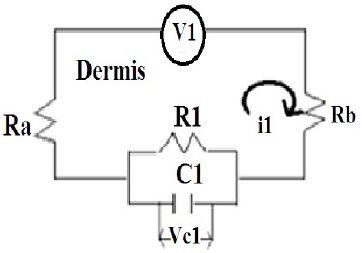
Figure 4. Equivalent Electrical System of Dermis